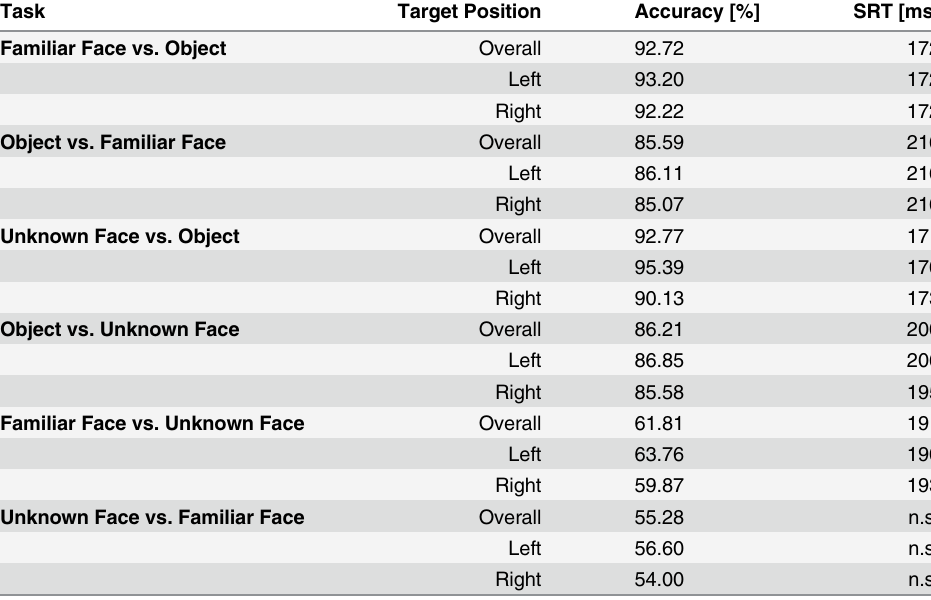
Table 1. Accuracy and mean RTs for each condition. Task Target Position SRT